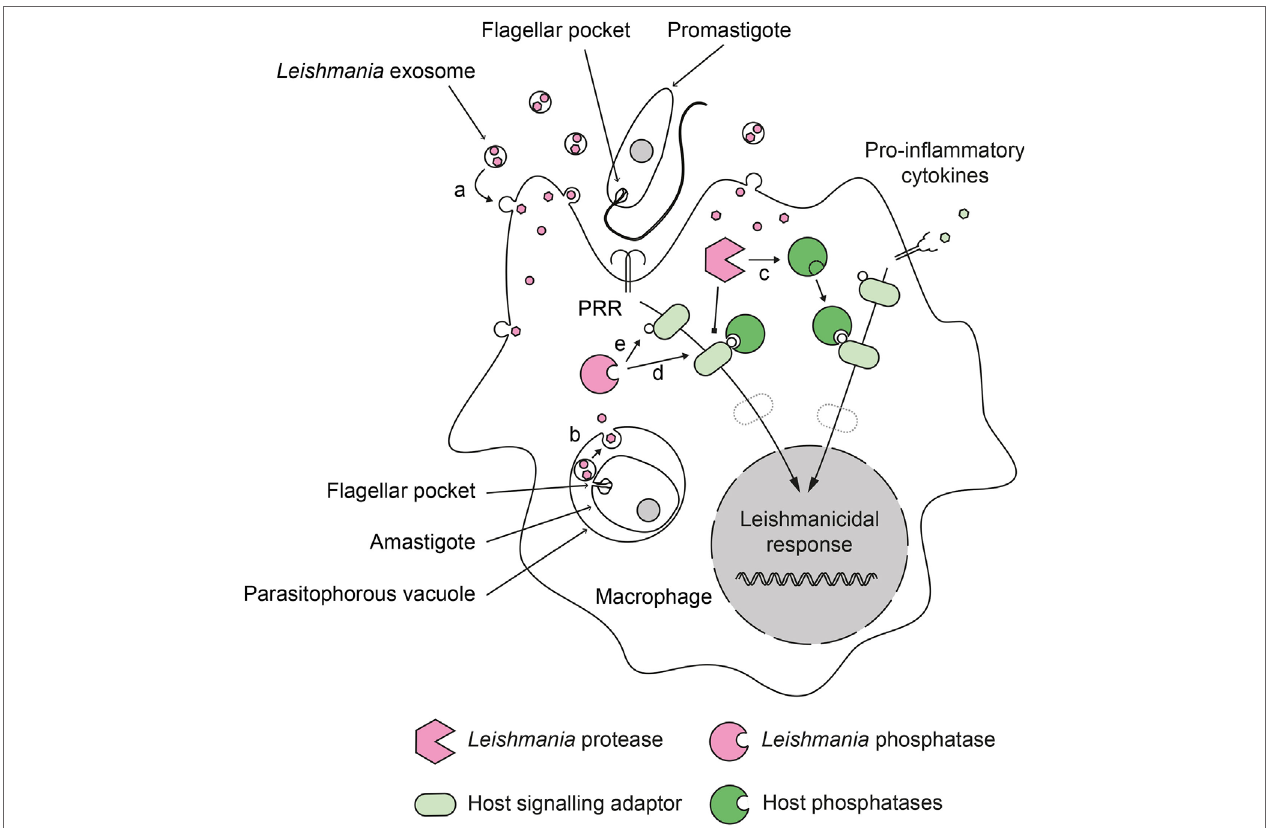
FigURe 1 | Role of phosphatases in the deactivation of host cell during Leishmania infection. Leishmania parasites have developed a dual strategy to inactivate important signaling pathways in their host cell. During infection, promastigotes and amastigotes secrete exosomes containing virulence factors. These exosomes release their content into the infected cells after fusing with (a) cytoplasmic membranes (in the case of extracellular promastigotes) or (b) phagosomal membranes (in the case of intracellular amastigotes). Secreted Leishmania proteases can proteolytically activate host phosphatases (c) that subsequently down regulate activating cellular pathways. Secreted Leishmania phosphatases could synergize with host phosphatases (d) or act independently (e) to modulate the infected cell